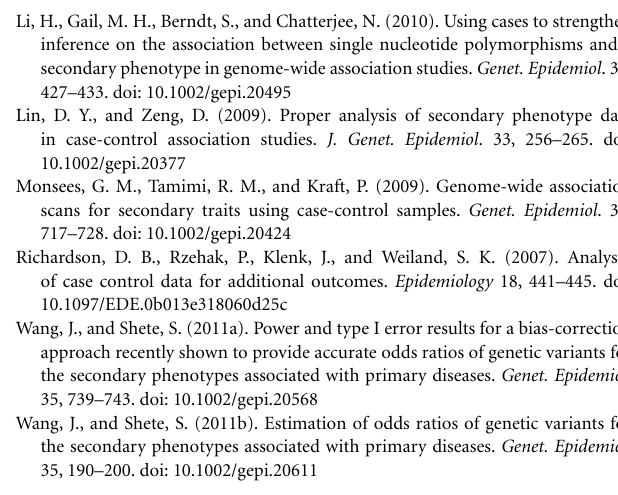
values and for data generated under the null hypothesis with γ 1 = log (1 . 5) and the disease rate equal 5%. The red dots on the plots represent the true maximum. The surface for β 0 and β 1 has a clear maximum whereas the surface for γ 1 and γ 0 is relatively flat, demonstrating the difficulty in maximizing the likelihood surface defined by Lin and Zeng under the null